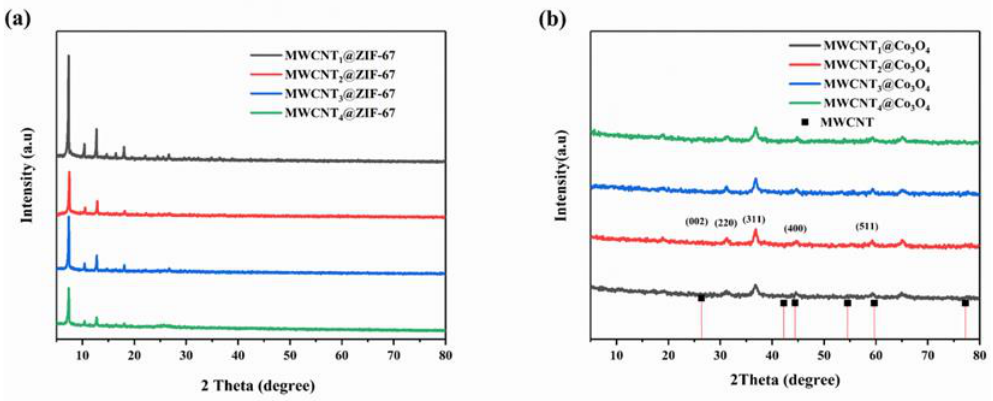
Figure 4. ( a ) XRD spectrum of MWCNTx@ZIF-67; ( b ) XRD spectrum of MWCNTx@Co 3 O 4